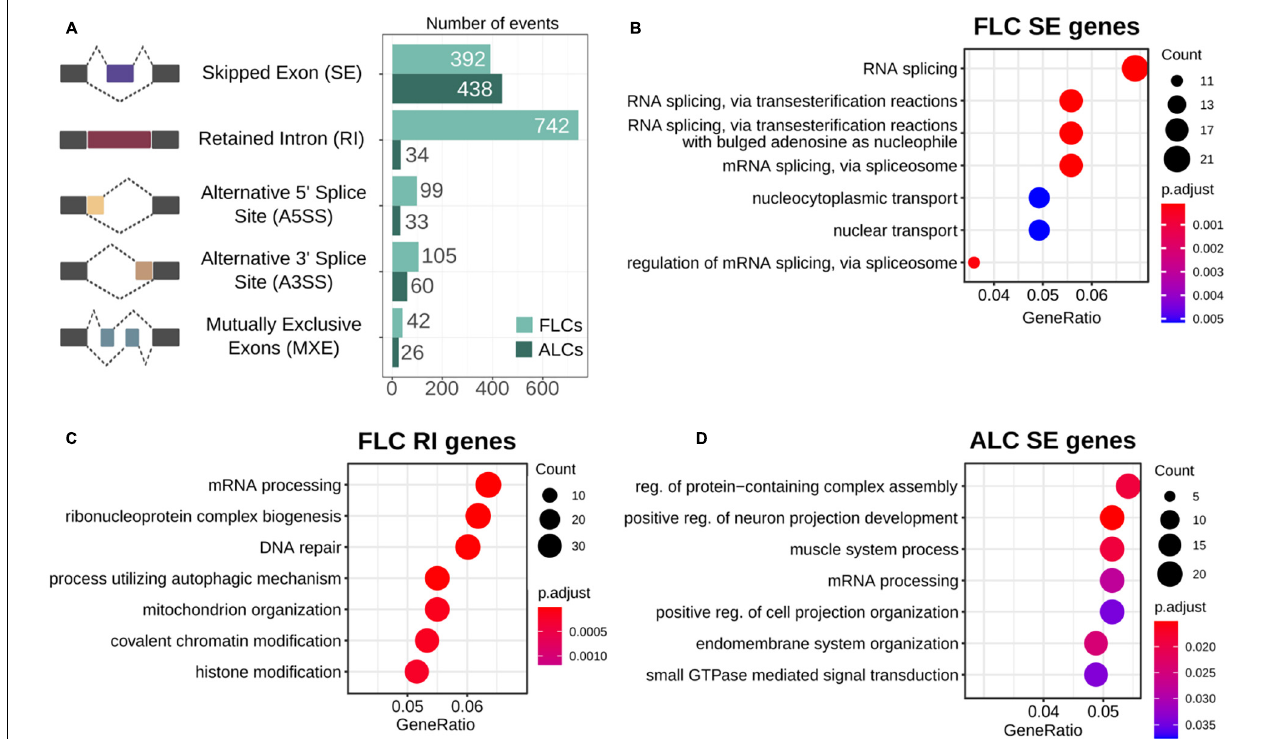
FIGURE 2 | Alternative splicing. (A) Proportion of the differential alternative splicing events found in fetal and adult Leydig cells. (B–D) GO term enrichment of the biological functions in genes showing differential skipping exons in fetal and adult Leydig cells (B,C) , and intron retention in fetal Leydig cells (D)